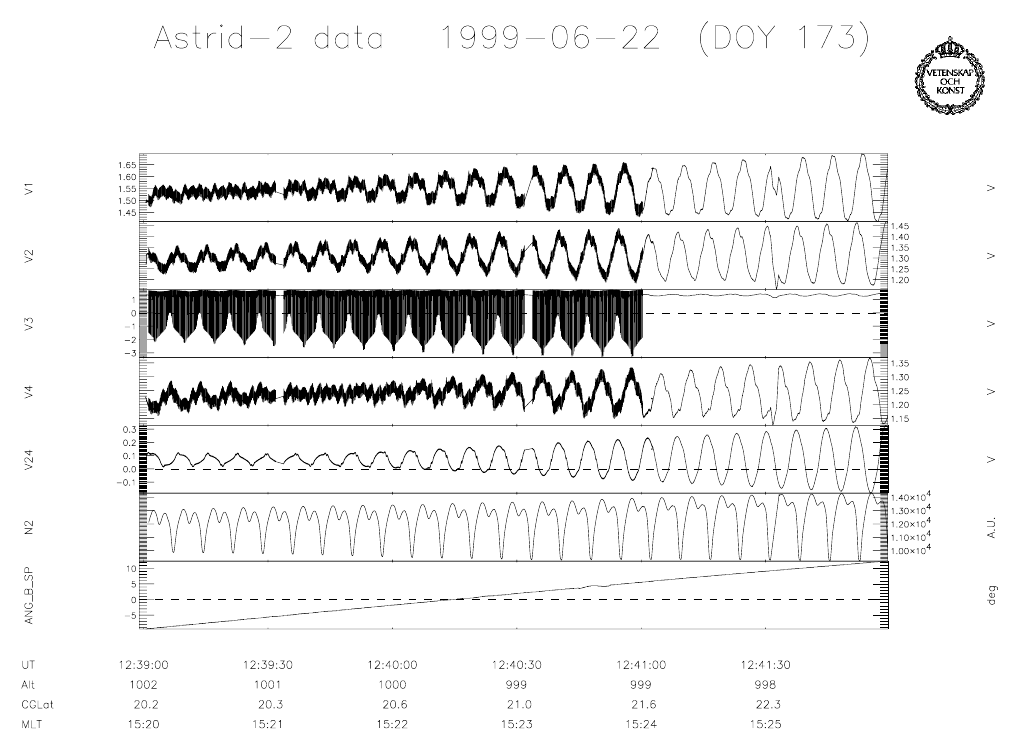
Fig. 5. EMMA measurements on 22 June 1999. Panels from top to bottom: potentials of probes 1 to 4 relative to the satellite, potential difference between probe 2 and probe 4, current collected by the LINDA probe, and angle α between B and the spin plane. Note the different scale in panel 3.